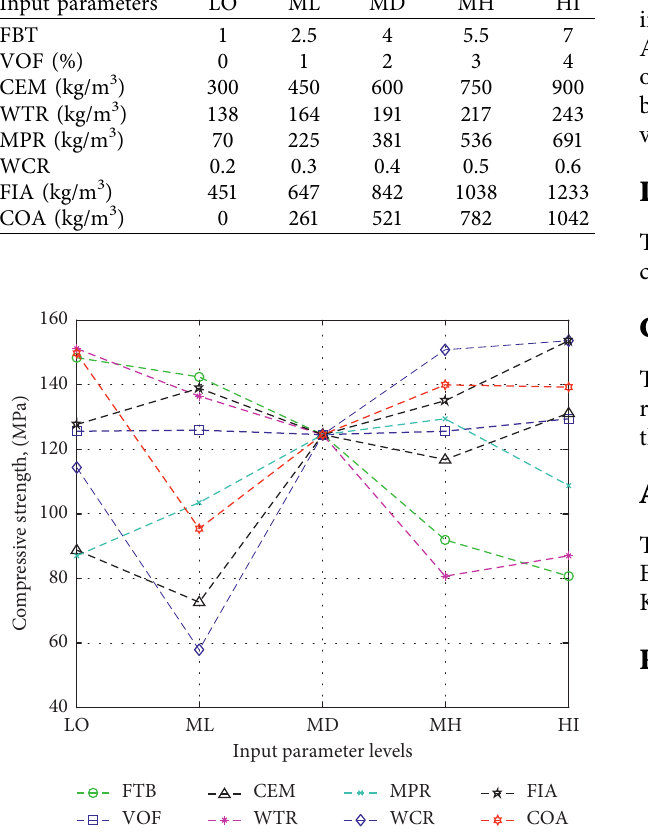
Figure 12: Compressive strength versus